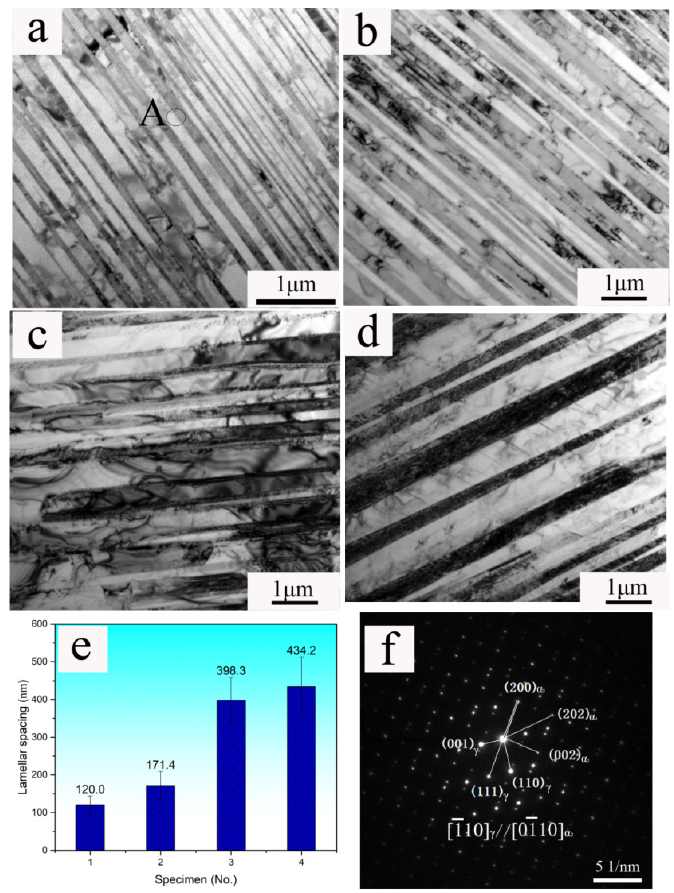
Figure 4. The TEM images of lamellar morphologies of S1 ( a ), S2 ( b ), S3 ( c ) and S4 ( d ), and their lamellar spacing ( e ). The selected area diffraction patterns of position A shown in ( f